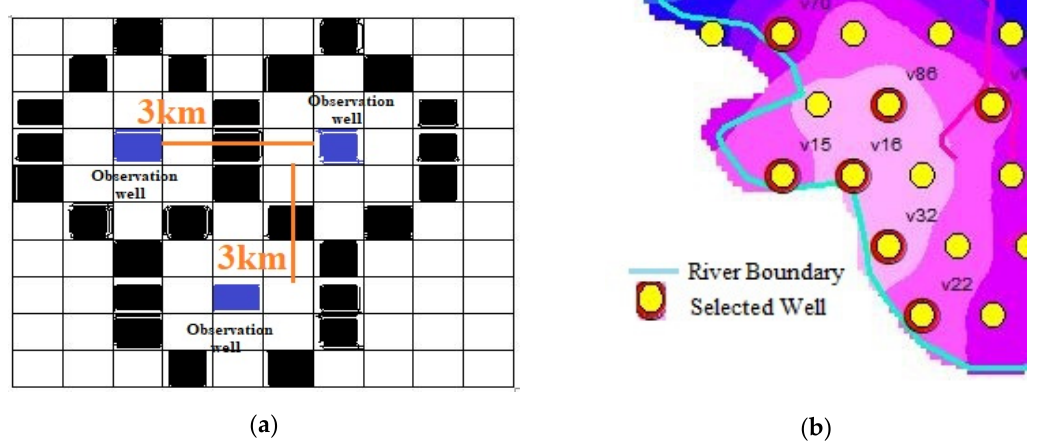
Figure 6. ( a ) Hexagonal pattern sampling scheme and ( b ) head classification sampling scheme.